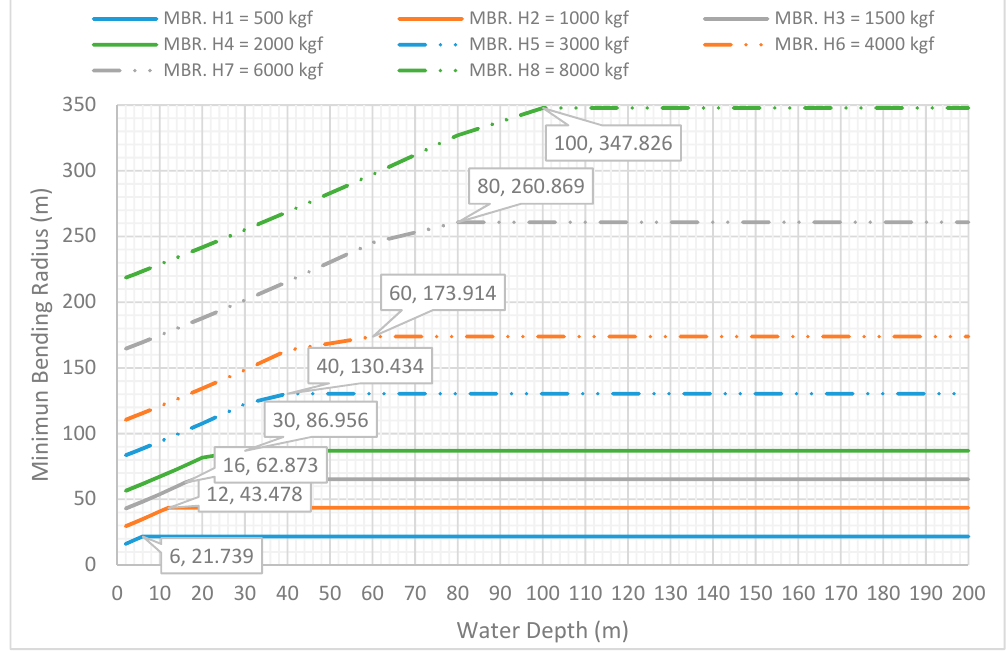
Figure 7. Minimum bending radius (=safety factor during laying) using various bottom tension values (500 kgf–8000 kgf) and water depths (2 m–200 m).